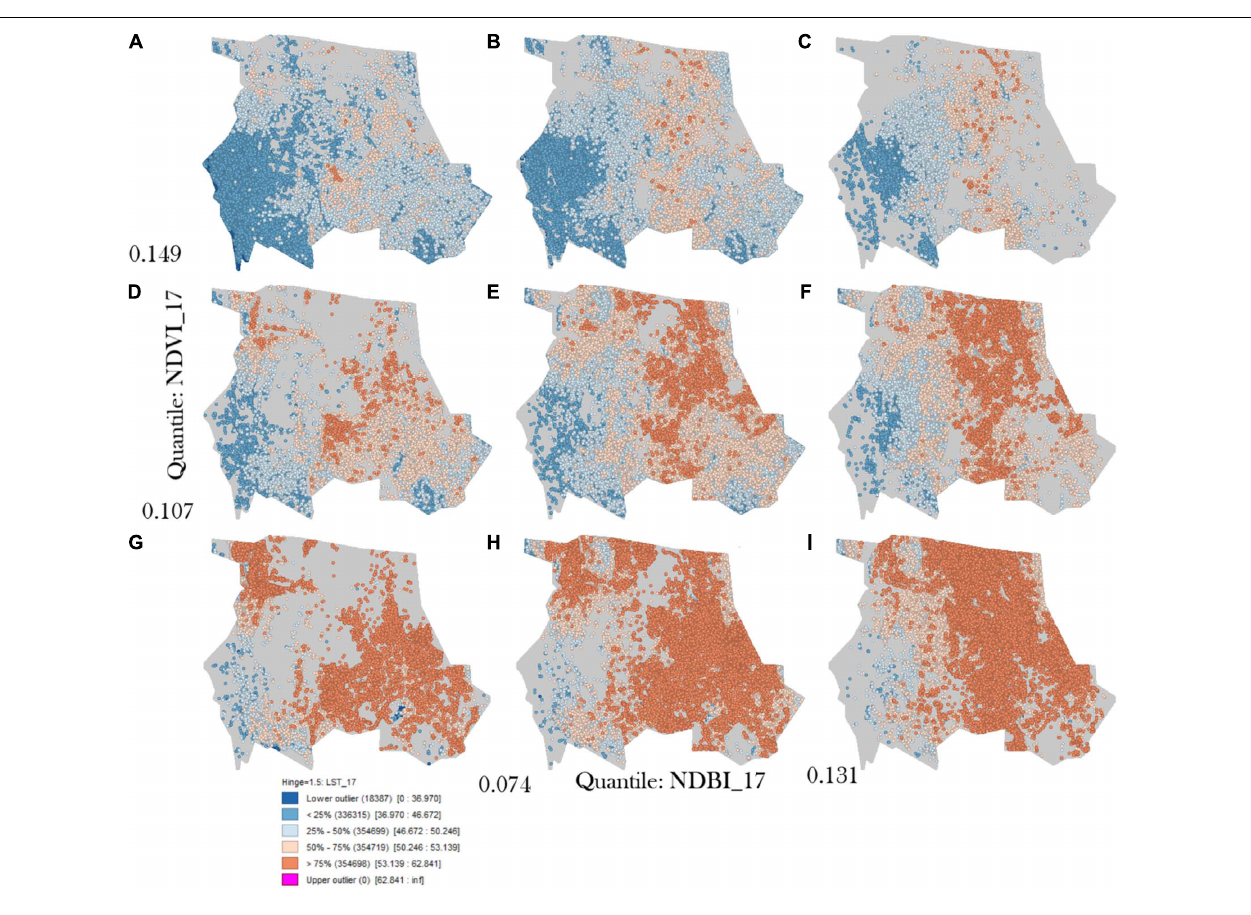
FIGURE 9 | (A–I) Conditional map of LST based on NDBI and NDVI for